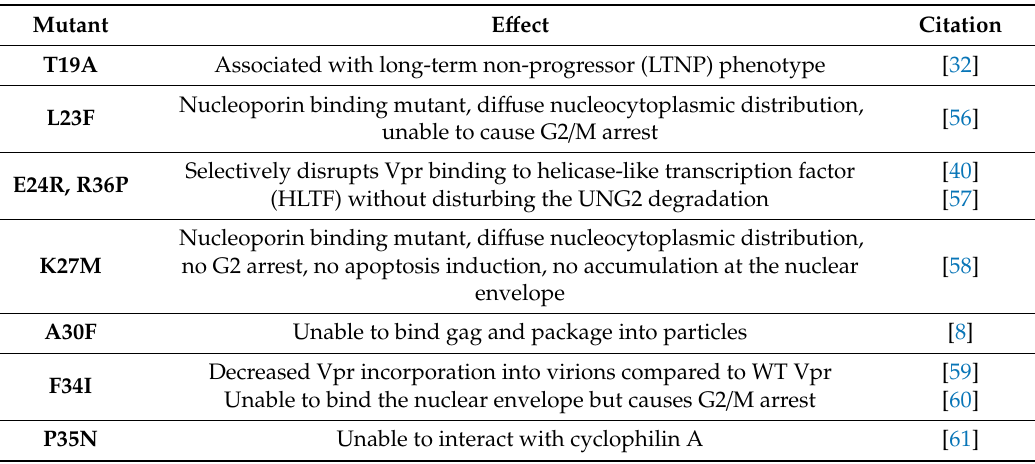
Table 1. Vpr mutants and their functional